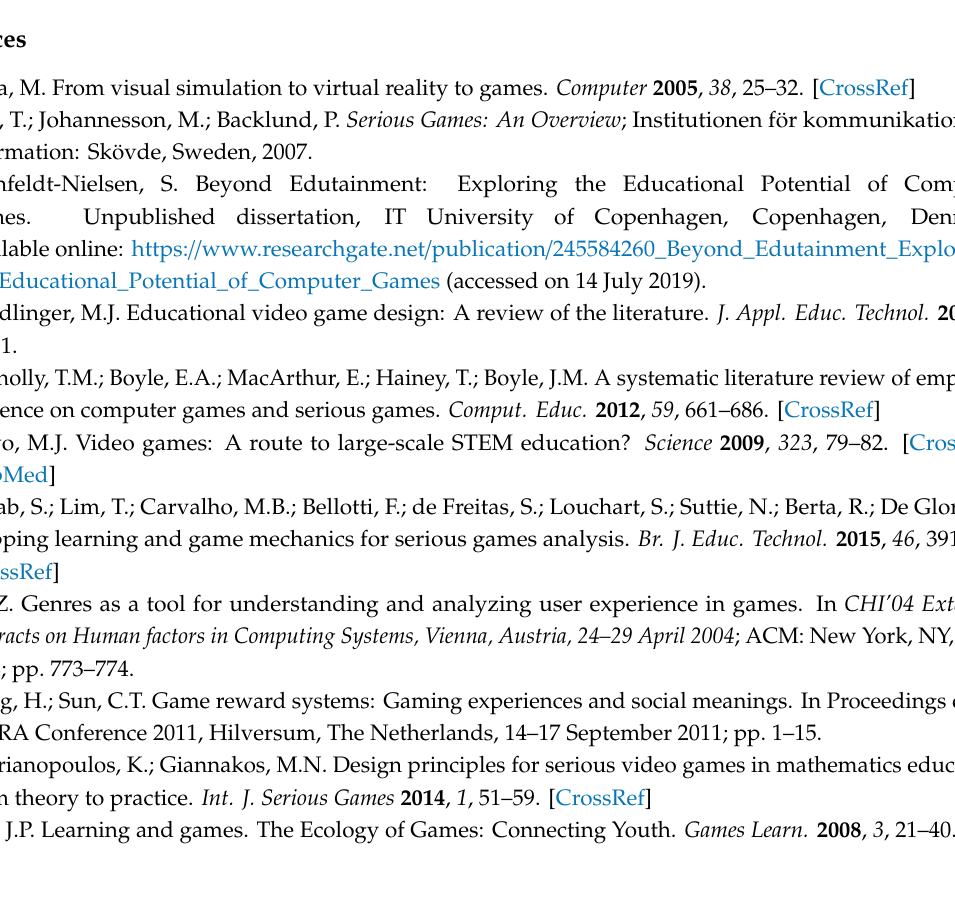
Figure A1. Adventure of Physical Sciences Game. Choose the most appropriate face to describe the